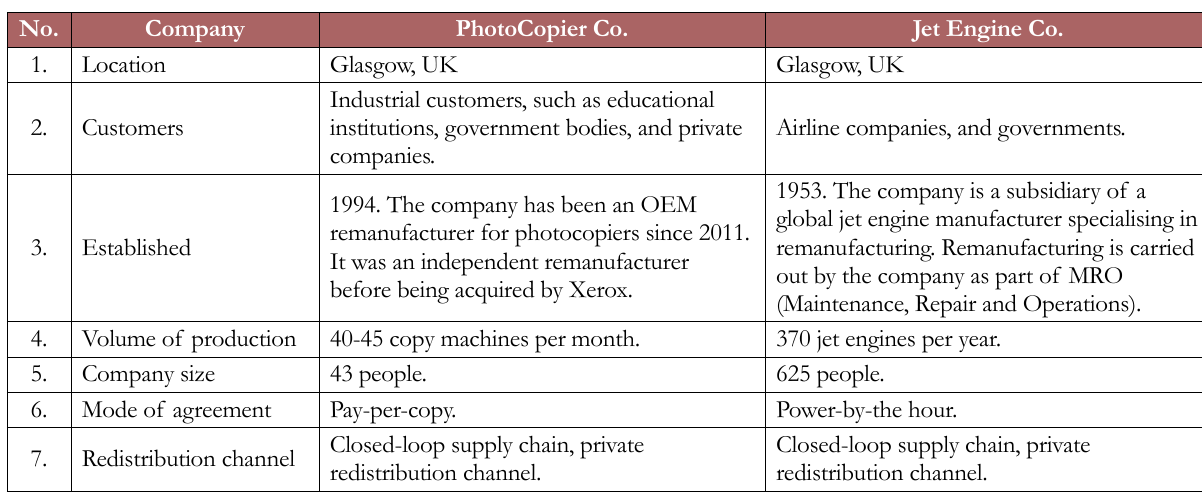
Table 1. Details of the case companies